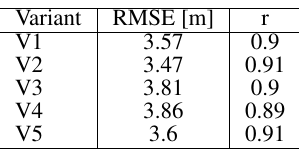
Table 3. Comparison of the performance of H-DSPEB to W-DSPEB, C-DSPEB and S2Shores.